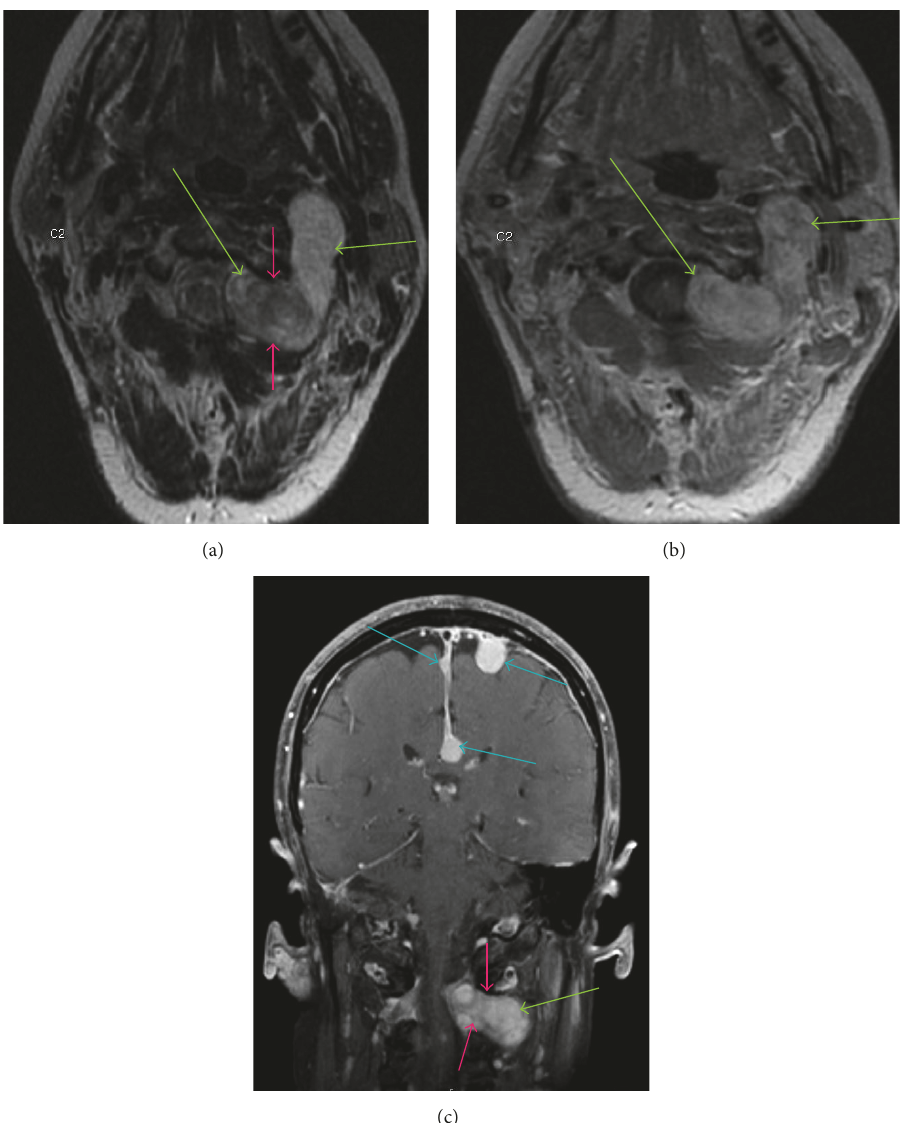
Figure8:AxialT2WI(Figure8(a)),axialpostgadolinium(Figure8(b)),andcoronalpostgadolinium(Figure8(c))demonstrateawell-defined extramedullary heterogeneously enhancing T2 hyperintense lobulated lesion representing a schwannoma (green arrow) extending along the left C2 nerve root in this patient with neurofibromatosis type 2 (NF2). This lesion causes effacement of left lateral thecal space at C1-C2 level and abuts the cervical spinal cord on the left, which is demonstrated on Figures 8(a) and 8(b). There is widening of left C1-C2 neural foramen (pink arrow) by this lesion. Additional multiple intracranial meningioma (blue arrows) are also identified on coronal postgadolinium image (Figure 8(c)) in this patient with